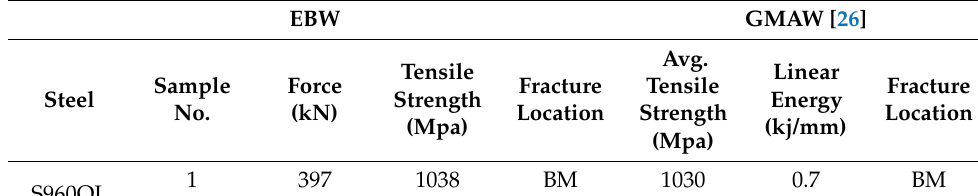
Table 10. Tensile properties of EBW and GMAW S960QLwelded joints.